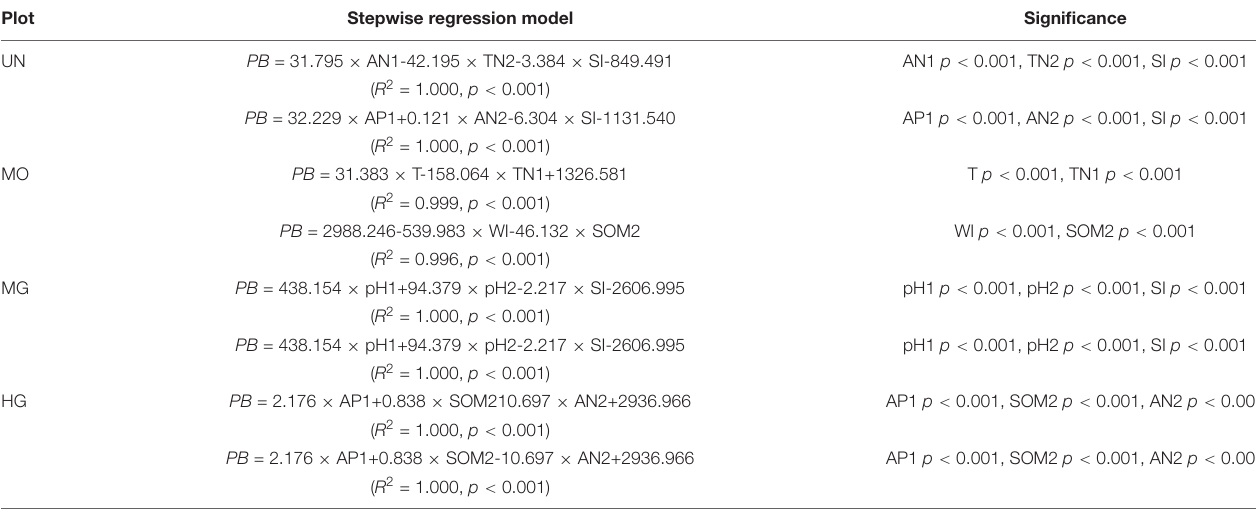
TABLE 3 | Key factors determining plant biomass under different utilization modes. Plot Stepwise regression model